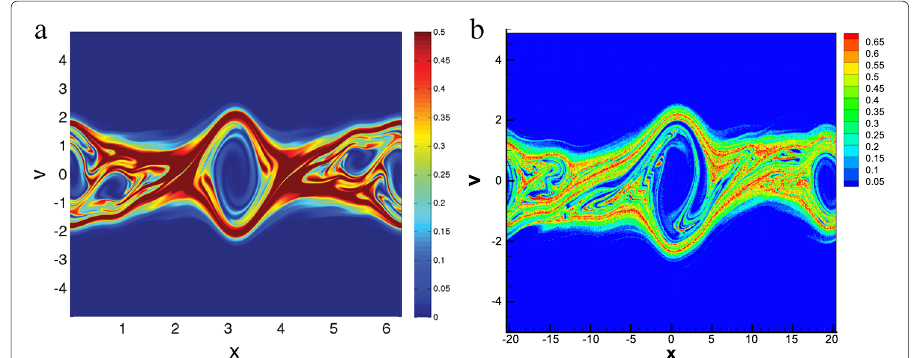
Fig. 6 Contour of the velocity distribution of the nonlinear two stream instability at t 70. Left figure shows the WENO result and right figure shows the UGKWP